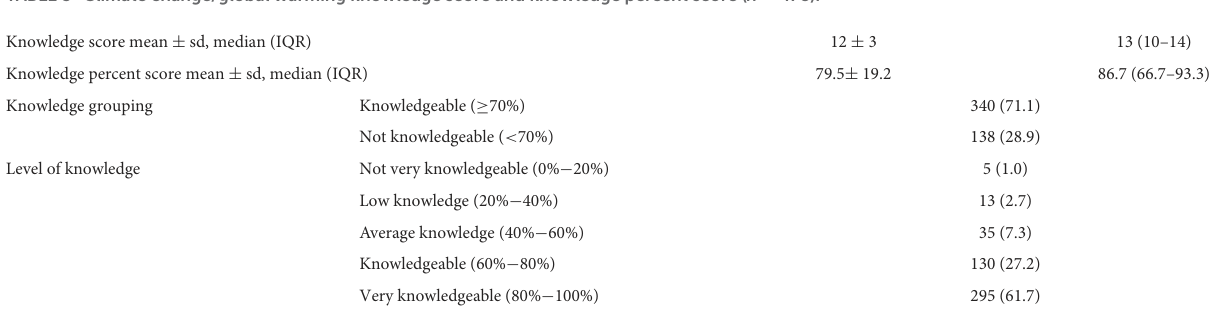
TABLE 3 Climate change/global warming knowledge score and knowledge percent score ( n =